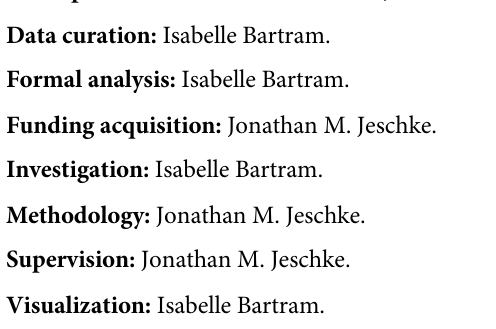
S1 Table. PRISMA 2009 checklist. From: Moher D, Liberati A, Tetzlaff J, Altman DG, The PRISMA Group (2009). Preferred reporting items for systematic reviews and meta-analyses: The PRISMA statement. PLoS Med 6(7): e1000097. doi:10.1371/journal.pmed1000097 S2 Table. Dataset of empirical tests. Tests and results from 51 studies testing the Cancer Stem Cell hypothesis that were included in our